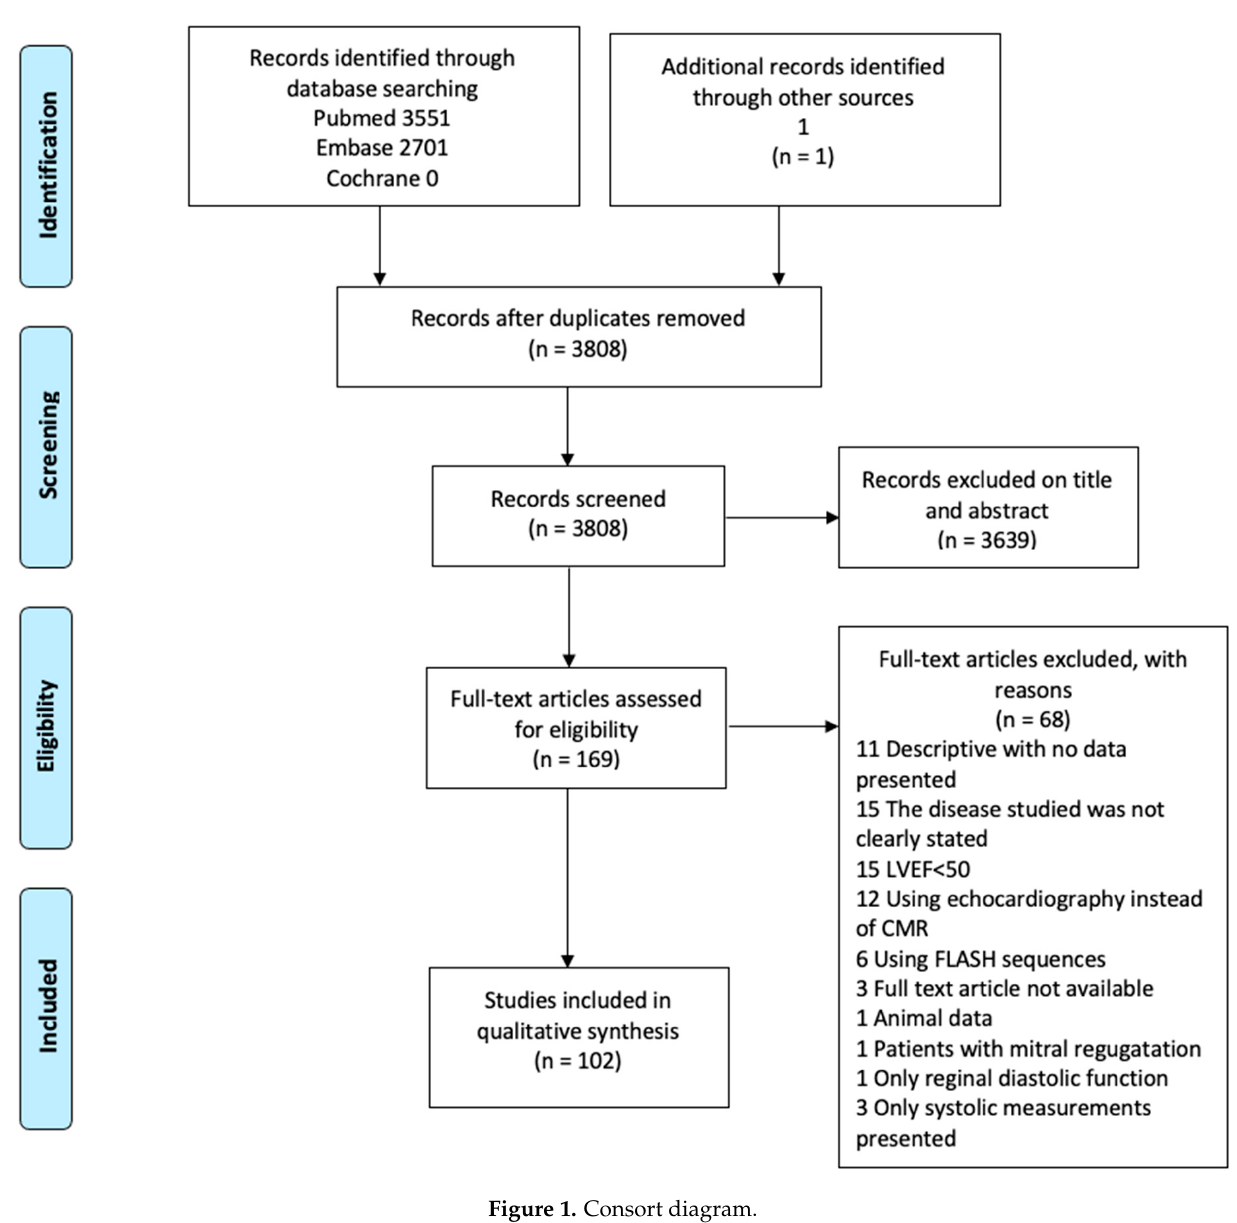
Figure 1. Consort diagram.